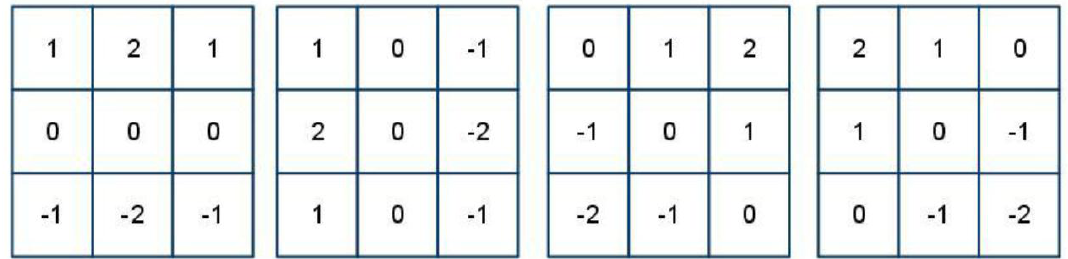
Figure 11. Four 3 × 3 Sobel operators in different orientations. Figure 11. Four 3 ˆ 3 Sobel operators in different